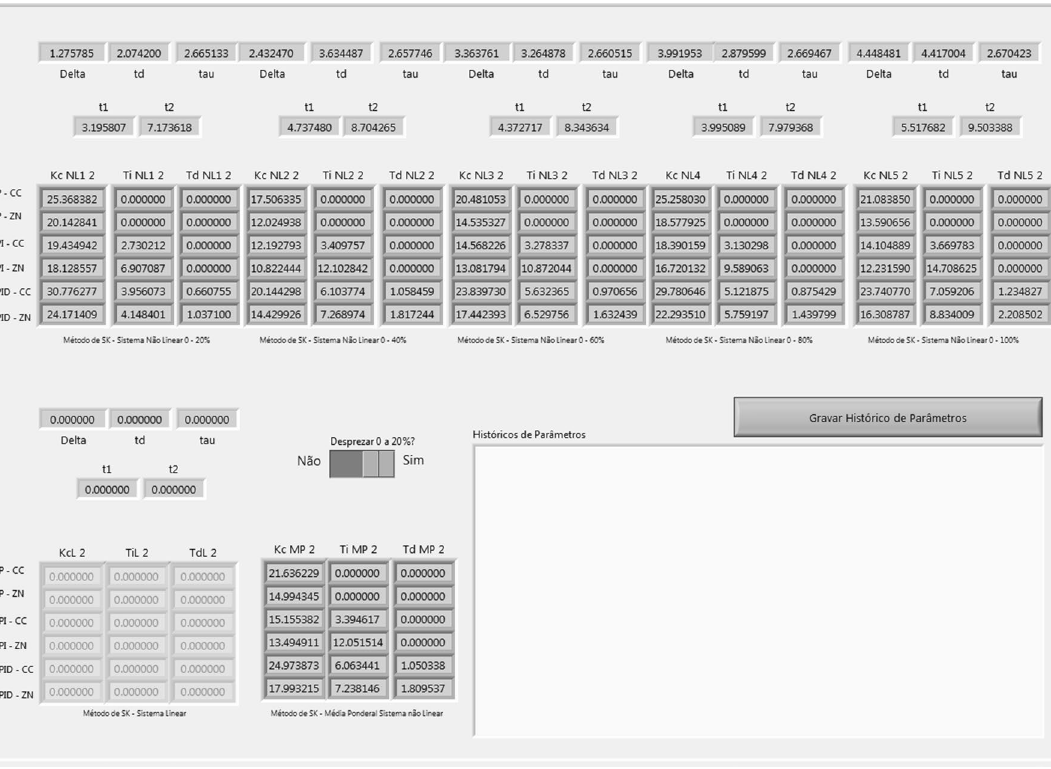
Fig. 7 Typical calculated parameters for a nonlinear system